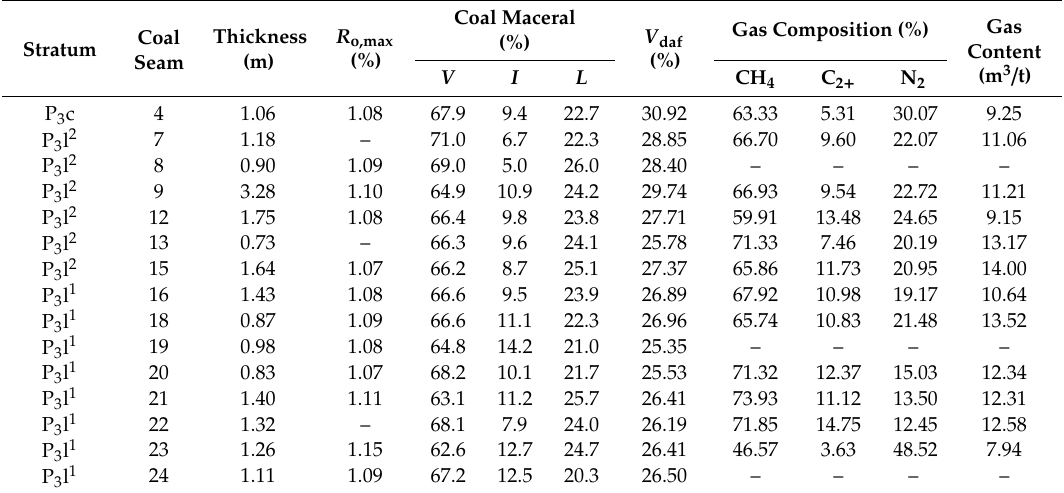
Table 1. Characteristic and gas content of main coal seam in the Bumu